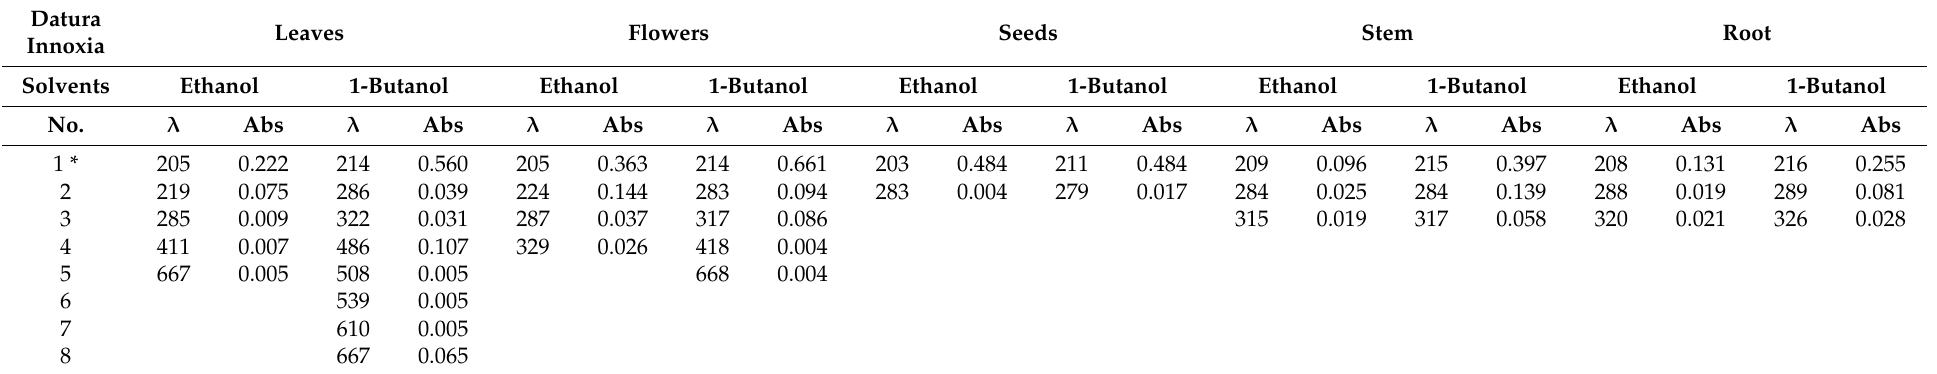
Table 1. UV–VIS measurement for peak values of 1-butanol and ethanol extracts of Daura innoxia dry